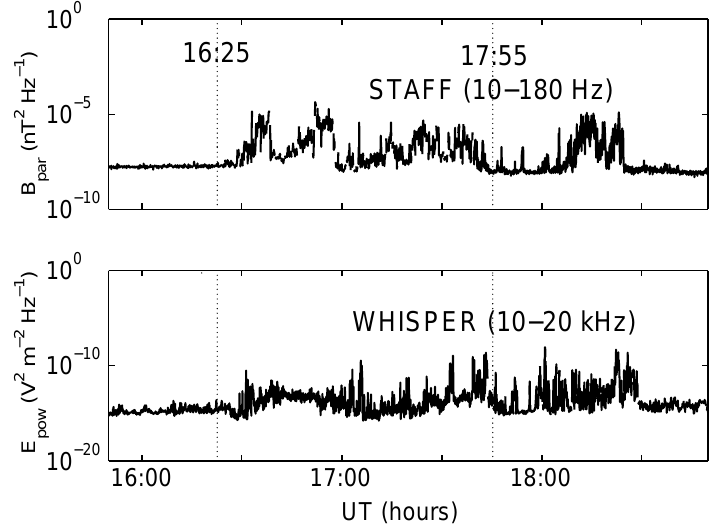
Fig. 6. Intensity of the magnetic waves (10–180Hz) parallel to the magnetic field measured by STAFF (top) and intensity of the electric waves (10–20kHz) measured by WHISPER (bottom) on Cluster SC3 during 15:50–18:50 UT on 18 April 2002.